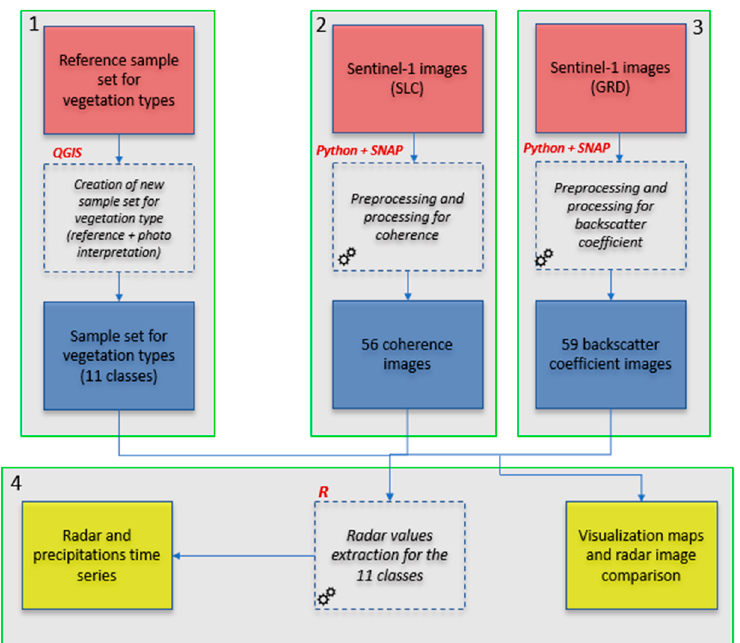
Figure 3. Process flowchart for identification of Phragmites australis in the delta by radar Sentinel-1. The red rectangles correspond to the basic data, the blue ones to the intermediate data, the yellow ones to the final products created, and those in dotted lines to the processing images.